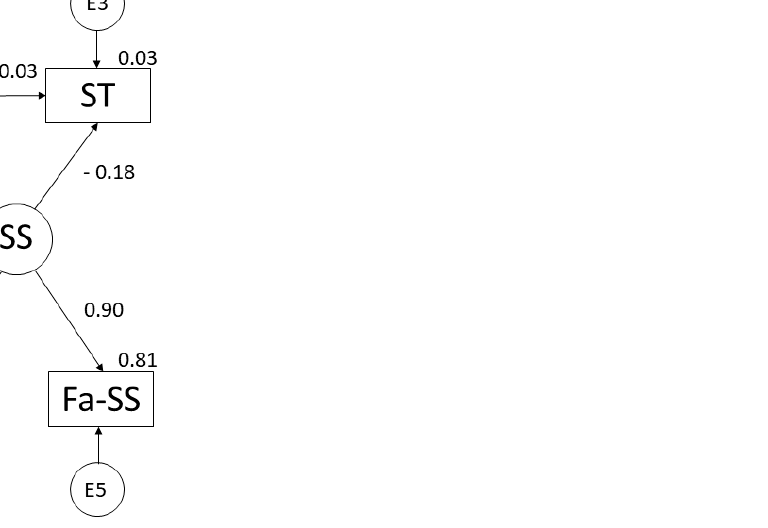
Figure 2. Suggested model for adolescent population. Note: Physical Activity (PA); Social Support (SS); Screen Time (ST); Family Support (Fa-SS); Friends' Support (Fr-SS).